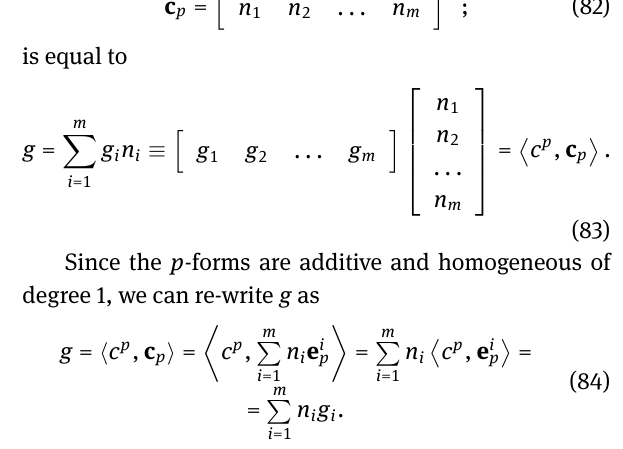
Figure 60: The coboundary